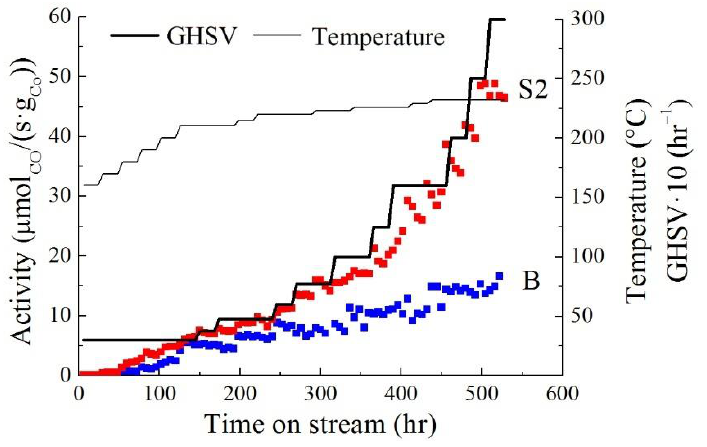
Figure 3. Activity of B and S2 catalysts.